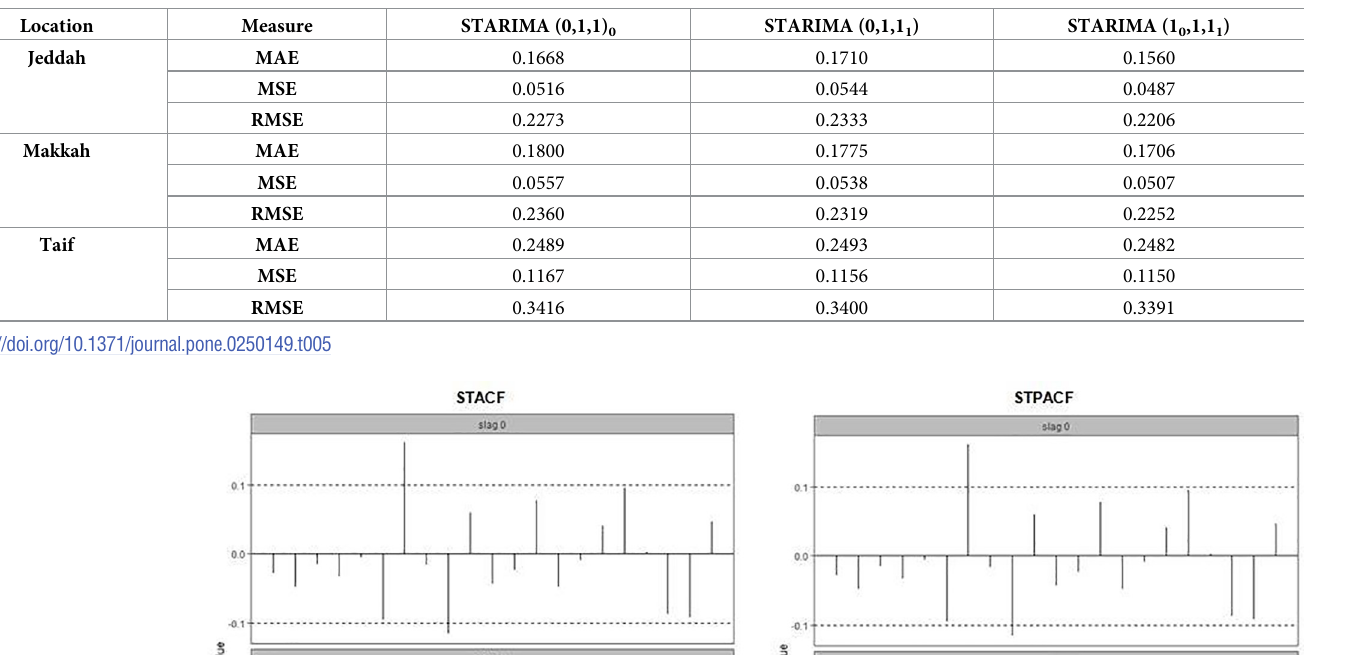
Table 5. Accuracy measures of STARIMA models.